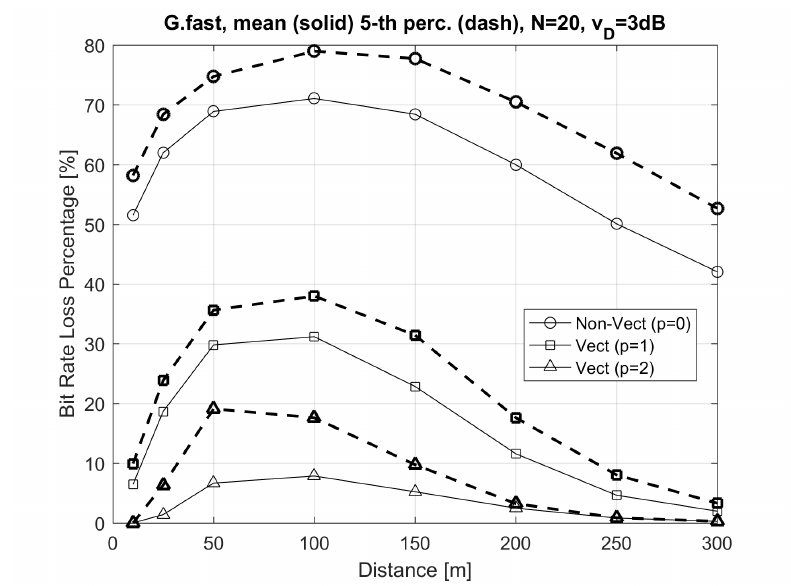
Figure 12. G.fast bit rate loss percentage as a function of distance. Non-vectoring ( p = 0 ) and vectoring, with p = 1 and p = 2, results are